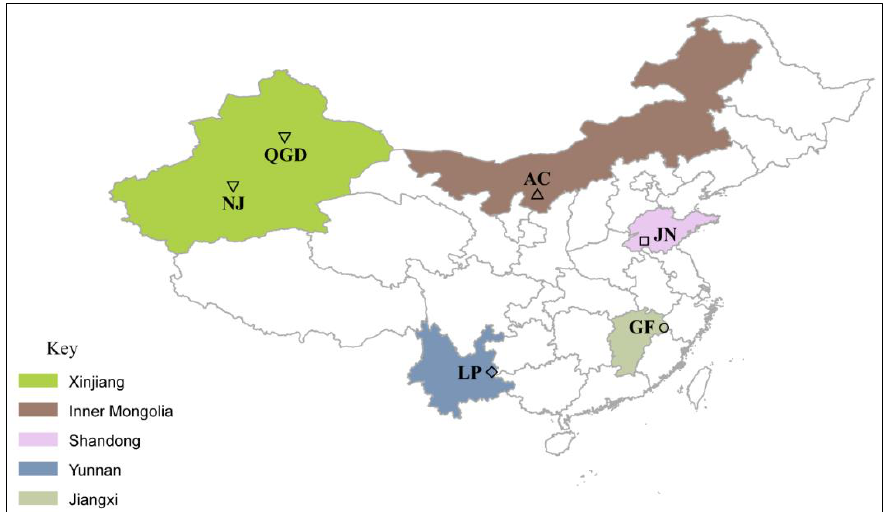
Figure 1. Geographic distribution and provinces of the six Chinese goat populations.